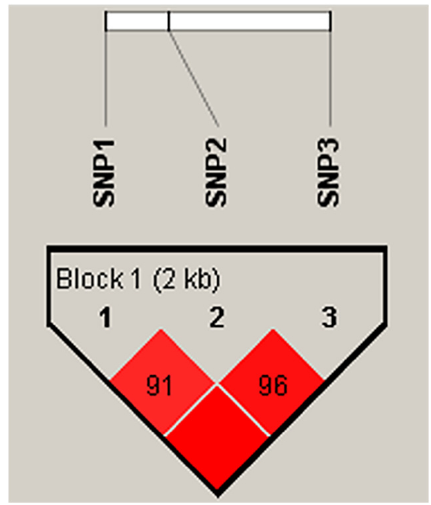
Figure 4. Linkage disequilibrium analysis of three SNPs of HIF-1 α gene. Table 4. Haplotypes and haplotype combinations of three SNPs of HIF-1 α gene.